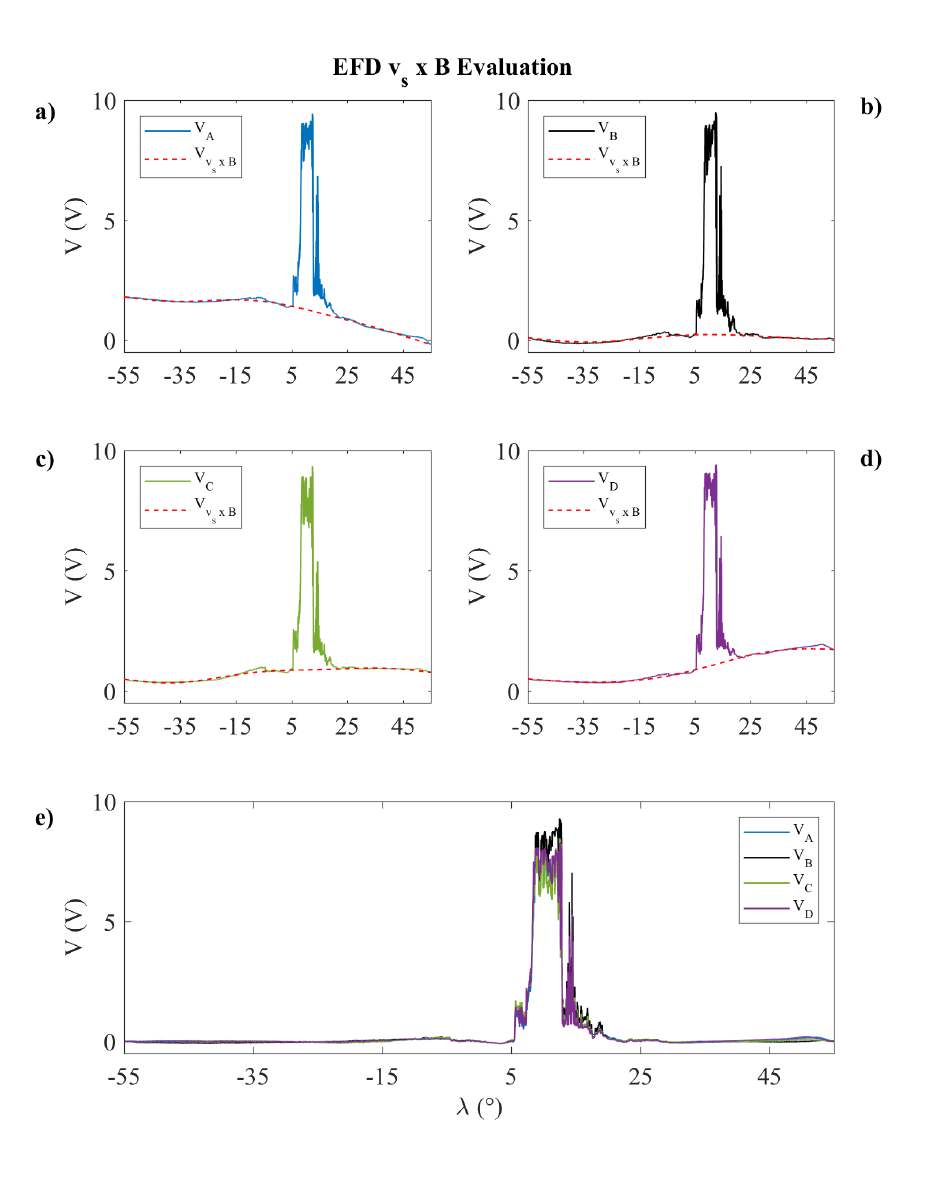
Figure 2. Upper panels (a, b, c, and d) show the probes potentials variations due to the v s × B geomagnetic field effect. The red dotted line represents the computed v s × B . The lower panel (e) shows the potentials when the computed v s × B . is subtracted from the measured value vs. the geographic latitudes λ